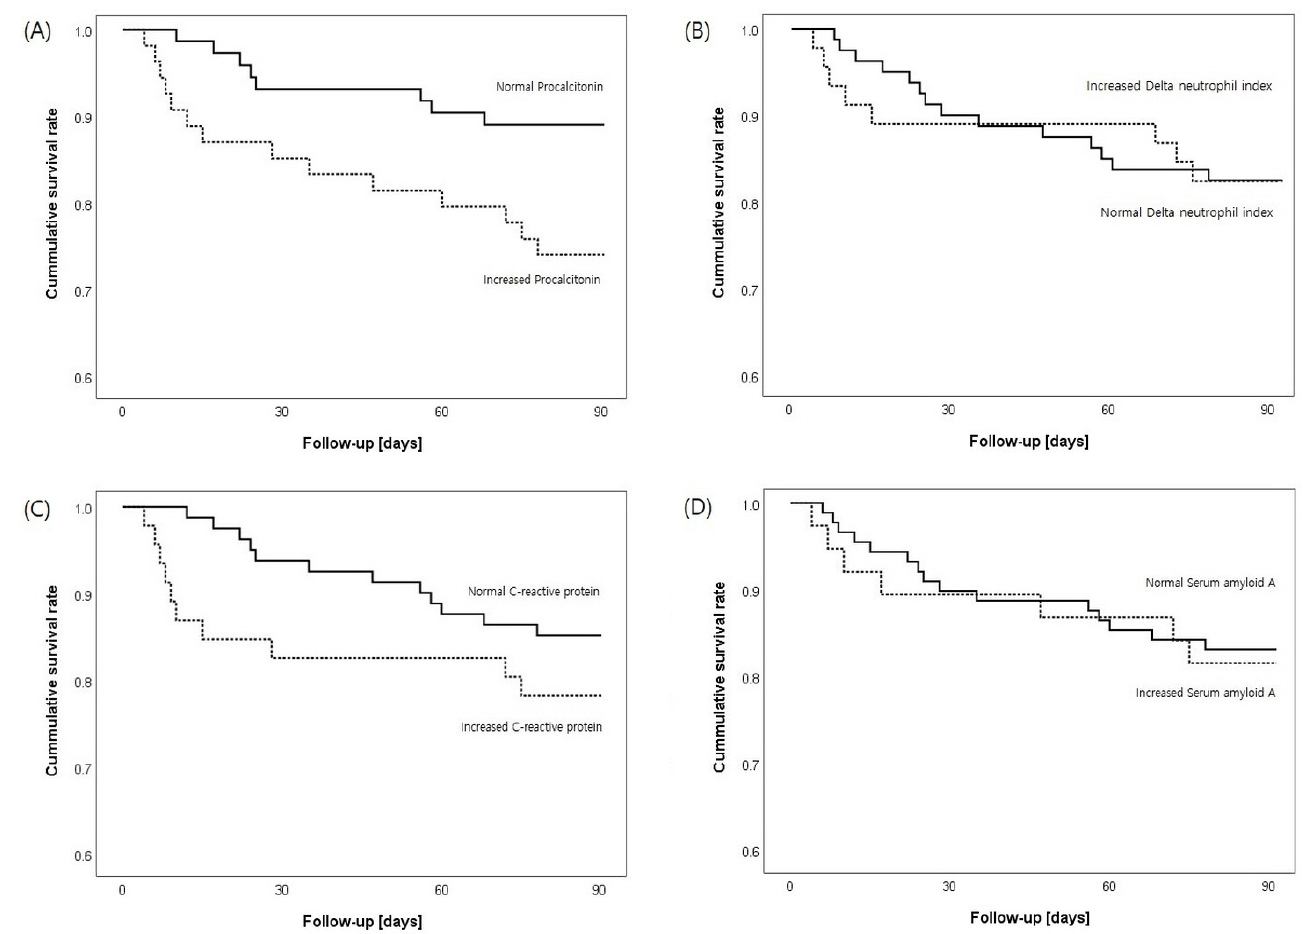
Figure 4. Kaplan–Meier survival estimates of patients by the levels of ( A ) procalcitonin, ( B ) delta neutrophil index, ( C ) C-reactive protein, and ( D ) serum amyloid A (mean and 95% confidence in- tervals).